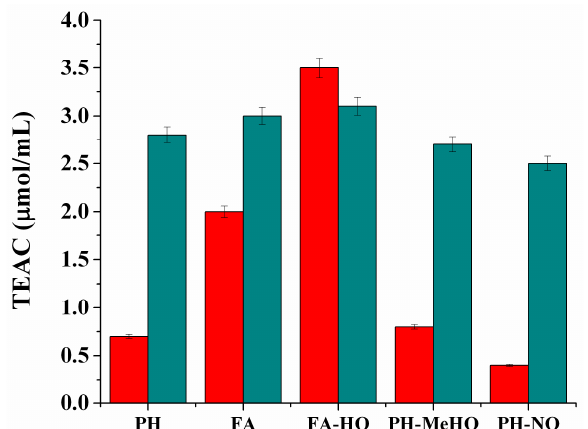
Figure 2. TEAC (Trolox equivalent antioxidant capacity) of HC and their quinone derivatives before NaBH 4 treatment (red columns) and after it (blue columns). PH : potassium humate. FA : fulvic acids. FA-HQ : fulvic acids after modification with hydroquinone. PH-MeHQ : potassium humate after modification with 2-methylhydroquinone. PH-NQ : potassium humate after modification with2-hydroxy-1,4-naphtoquinone.